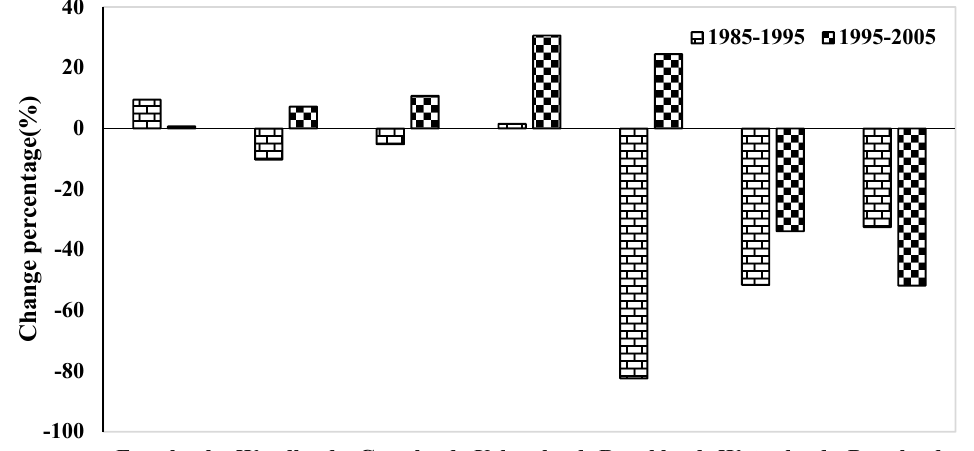
Figure 8. Change in area percentages of land cover types during the 1990s and 2000s compared to the baseline period.